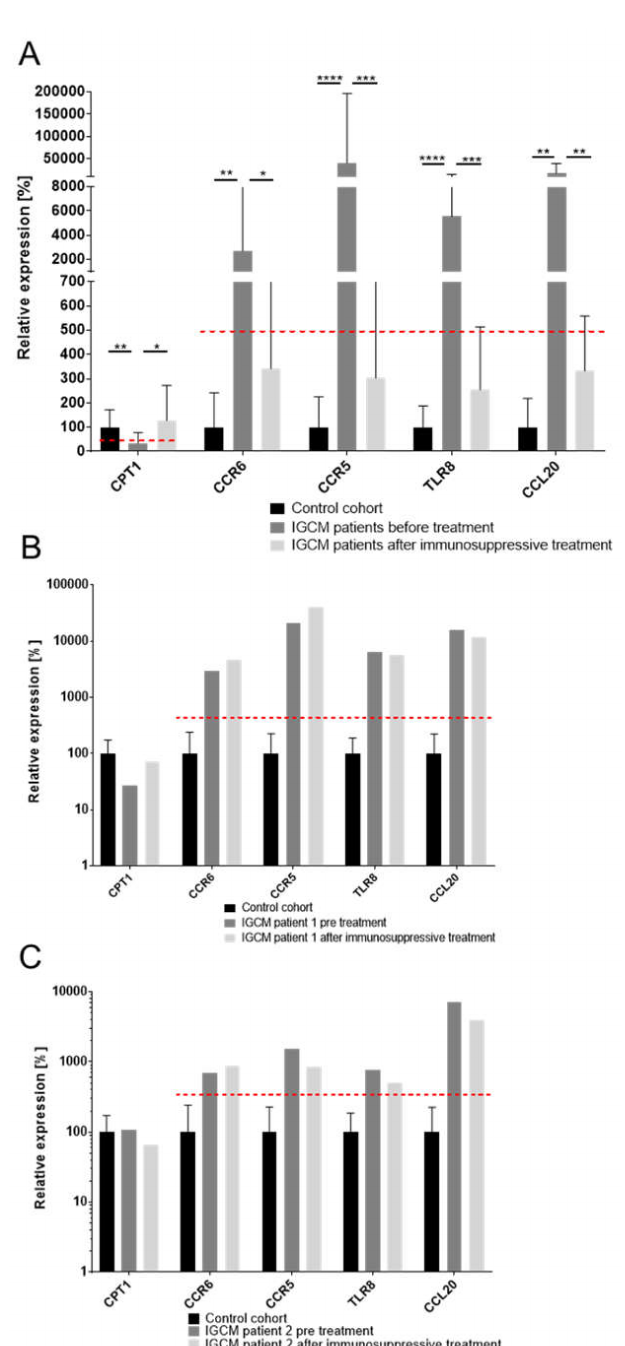
Figure 5. Analysis of Gene-Expression Dynamics Before and After Immunosuppressive Therapy of Patients with Histologically Proven and Gene Profile-Detected IGCM. ( A ) The gene expression of marker genes for IGCM were measured before and after applying immunosuppressive therapy and were compared to a healthy control cohort in patients with normalized gene-expression profiles at follow-up; the results indicated successful treatment. The mean expression for marker genes CPT1 , CCR6 , CCR5 , TLR8 and CCL20 normalized at follow-up and fell below a clinically relevant threshold but did not reach the expression level of the control cohort. A dashed line indicates a clinically relevant threshold for the specific gene expression. ( B ) and ( C ) The gene expression of marker genes observed in two IGCM patients who exhibited persistent inflammation at follow-up along with a gene profile that suggested persistence of GCs after treatment. P -values are denoted by asterisks: * p ≤ 0.05, ** p ≤ 0.01, *** p ≤ 0.001, **** p ≤